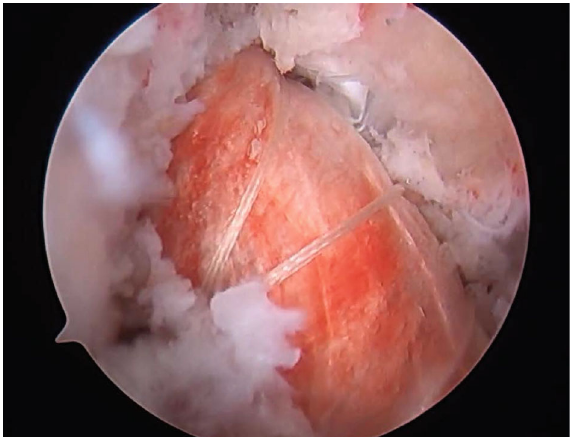
Figure 3: The graft has been secured into the femoral tunnel. The PRP-soaked collagen wrap maintains the biologic agent within the aqueous